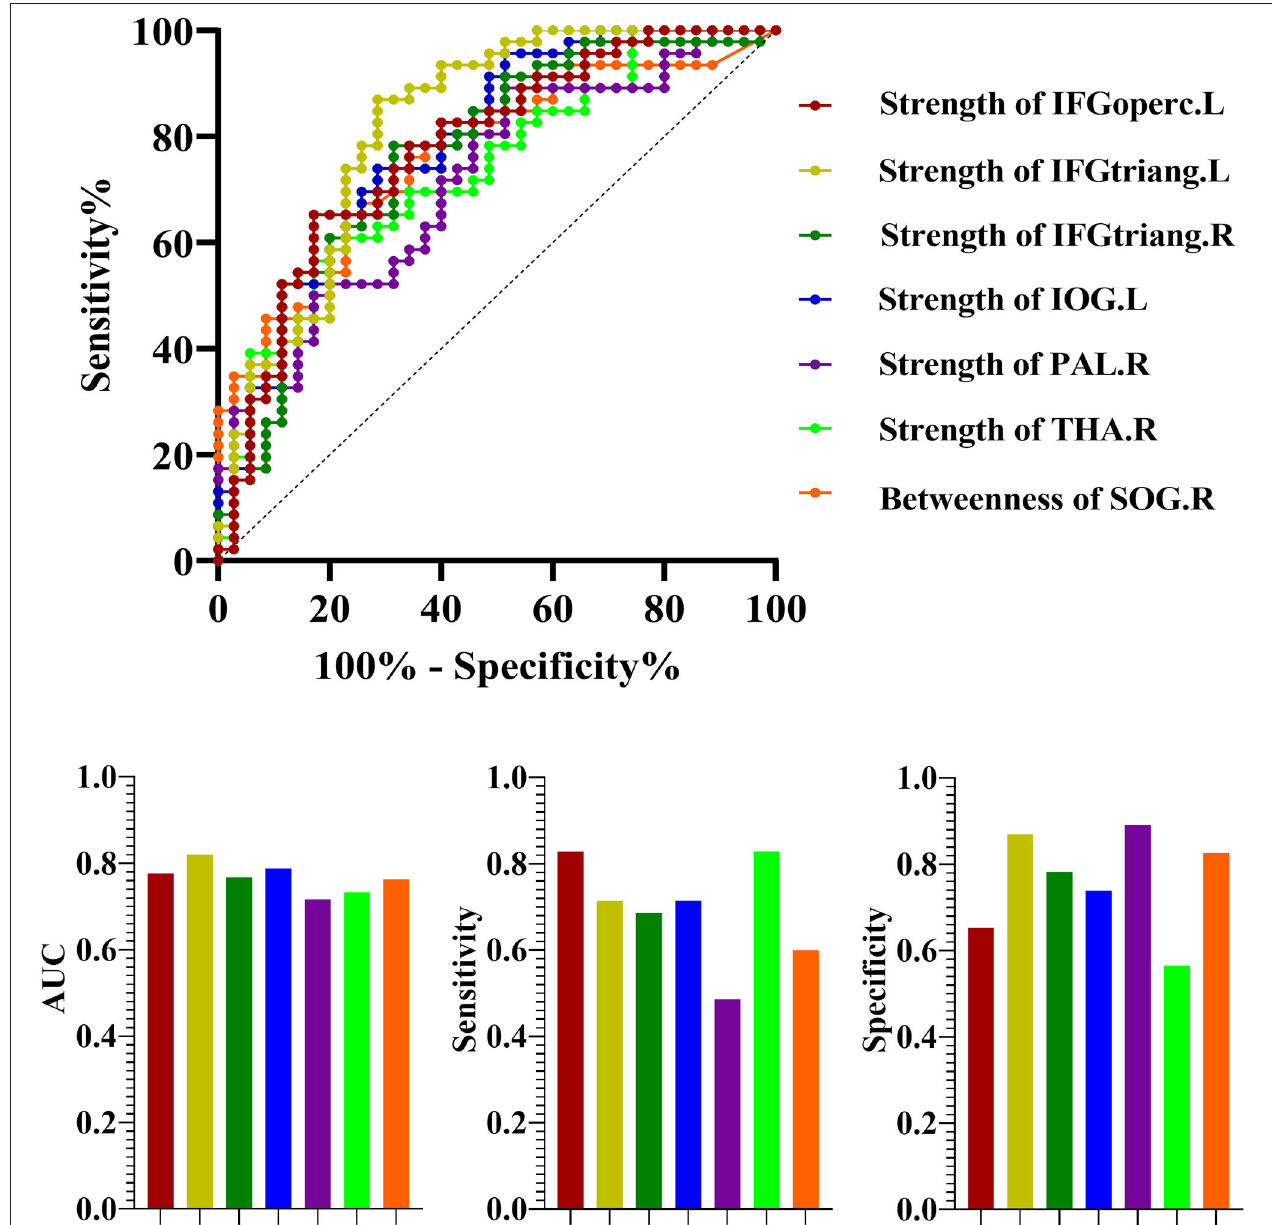
FIGURE 5 | The receiver operating characteristic curve (ROC) for discrimination between NSCLC and HC. NSCLC, non-small cell lung cancer; HC, healthy control; AUC, area under the curve. The abbreviations of brain regions were presented in the Supplementary Material online.